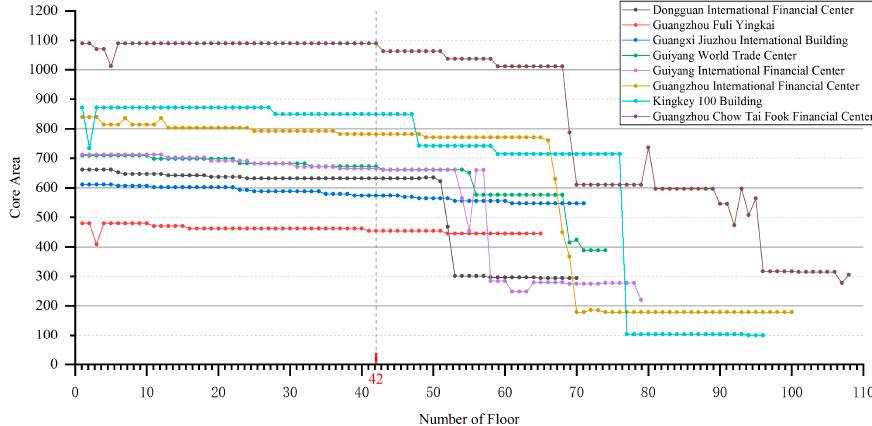
Figure 12. Variation of the core area of the typical floor.